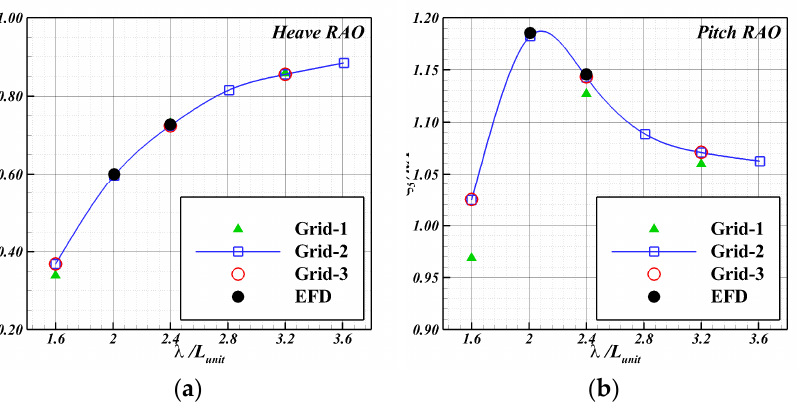
Figure 13. Comparison of motion RAOs according to grid conditions: ( a ) heave; ( b ) pitch.